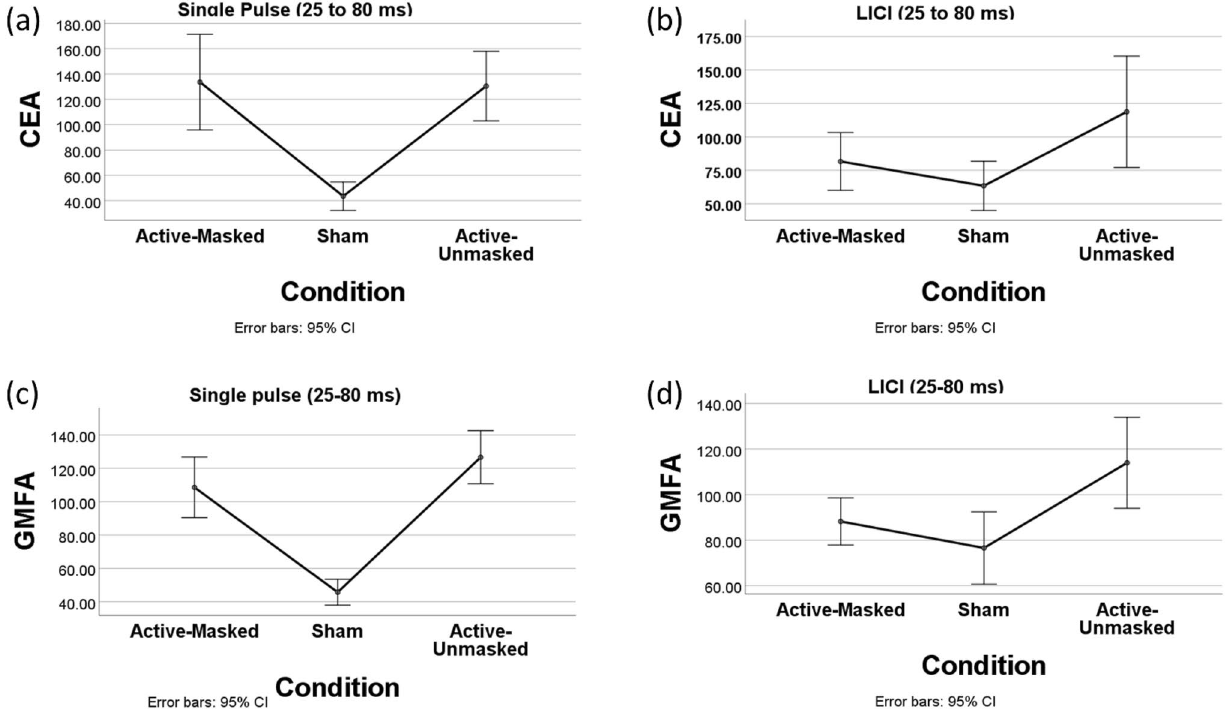
Figure 5. ( a ) Comparison of CEA (25–80 ms) for the three single pulse conditions using one-way repeated measure ANOVA. ( b ) Comparison of CEA (25–80 ms) for the three long interval cortical inhibition (LICI) conditions using one-way repeated measure ANOVA. ( c ) Comparison of GMFA (25–80 ms) for the three single pulse conditions using one-way repeated measure ANOVA. ( d ) Comparison of GMFA (25–80 ms) for the three LICI conditions using one-way repeated measure ANOVA. CEA is recorded from electrode F3. GMFA reflects the activity recorded across all the